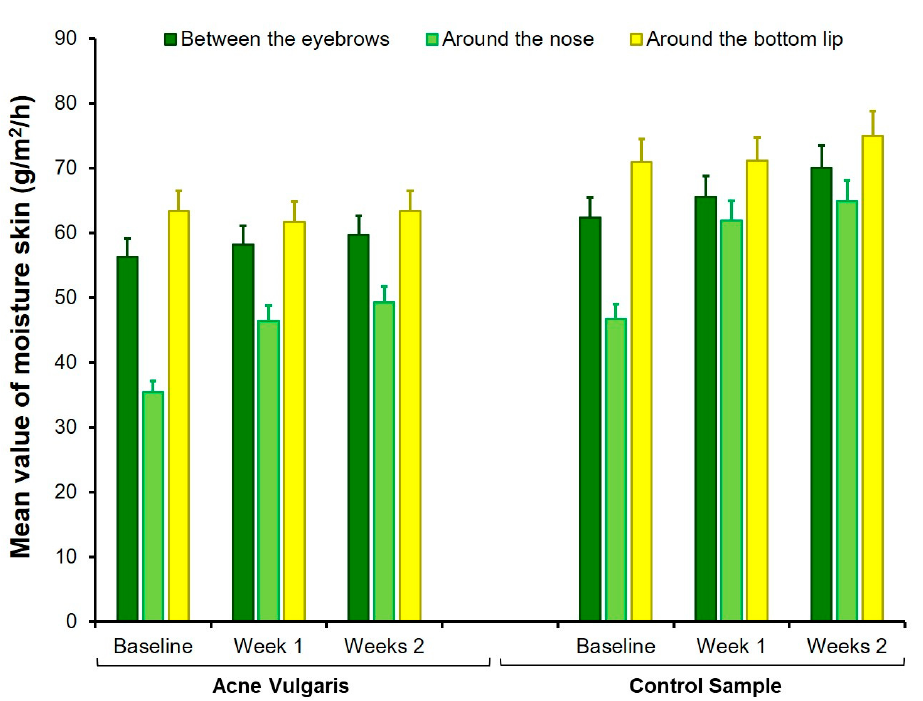
Figure 7. Comparison of mean values of moisture skin at baseline, one week, and two weeks after finishing the treatment with hydrogen purification in both AV and CS groups. Error bars are standard deviations.